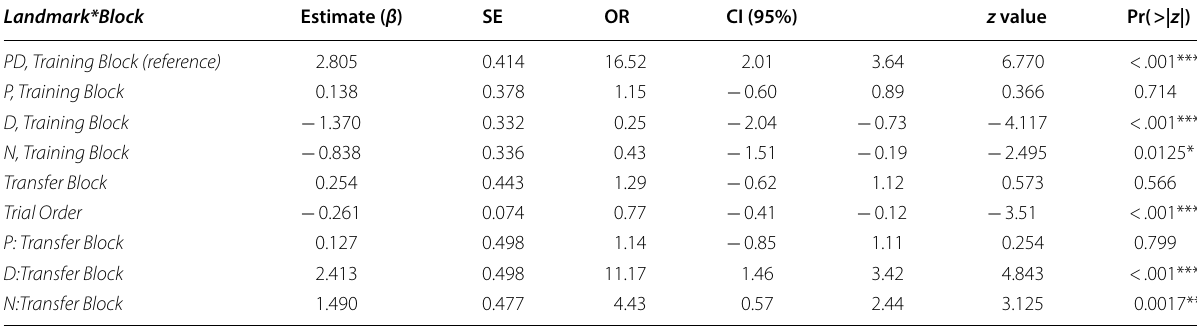
Asterisks “***”, “**”, and “*” denote p < .001, p < .01, p < .05, respectively